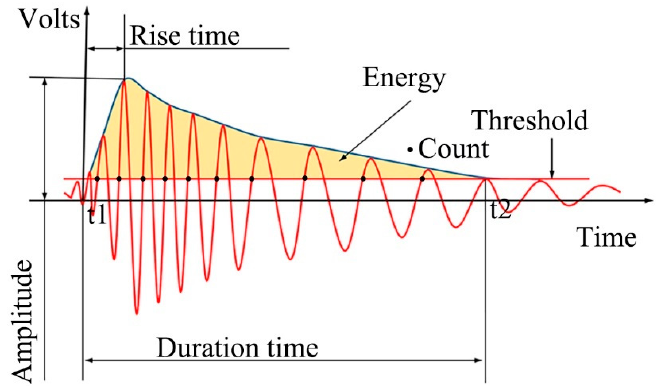
Figure 3. Simplified waveform of standard AE signals [23,25,29].